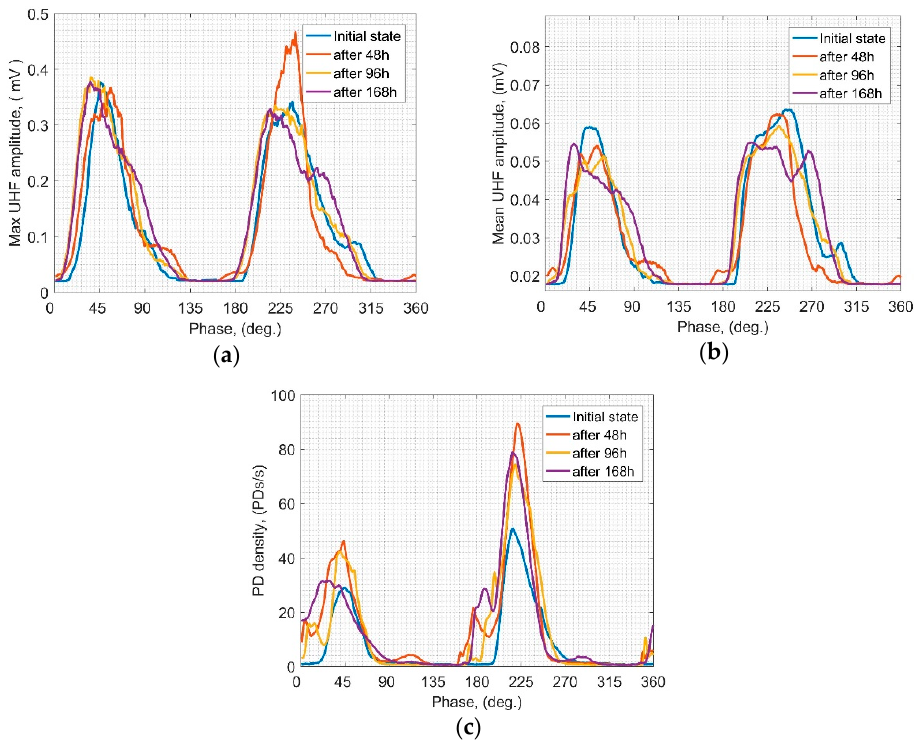
Figure 5. Means over PRPD patterns of the UHF signals emitted by SD for GLS scenario: ( a ) max UHF amplitude; ( b ) mean UHF amplitude; ( c ) PD density.